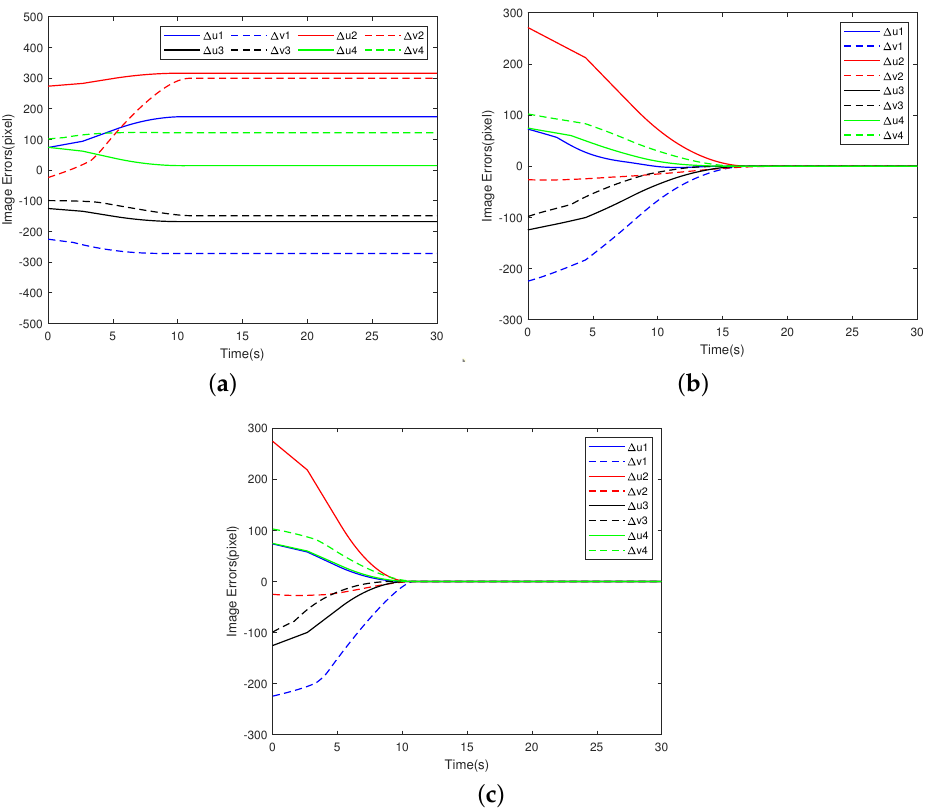
Figure 5. Image errors of comparative simulations with model uncertainty. ( a ) Image errors in Case 1. ( b ) Image errors in Case 2. ( c ) Image errors in Case 3.